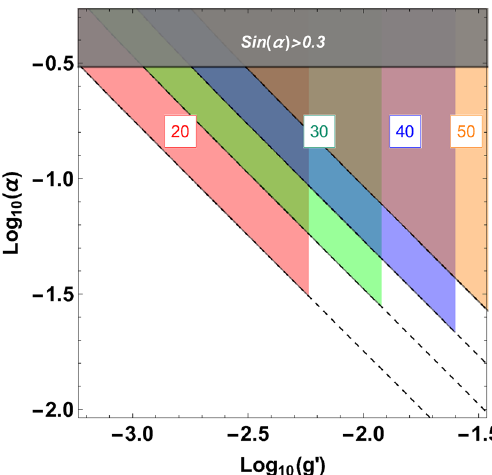
Fig. 4 Allowed region of the parameters in log ( g (cid:2) ) -log (α) plane. Red, green,blueandorangecoloredregionaretheexclusionregionfor m Z (cid:2) = 20 , 30 , 40 and 50 GeV from h → 4 l search at 2 σ . Dashed lines representthecontouroftheupperboundofBr ( h → 4 l ) giveninTable2. Gray shaded region is excluded by analysis of data regarding the SM Higgs signals from the LHC experiments